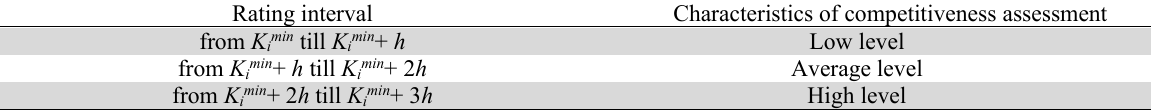
Fig. 1. Number of young people aged 15-29 who completed the transition to the labor market by regions of Ukraine To formalize the assessment of the regions of Ukraine by competitiveness of young people in the labor market, we will make the following transformation: we will give the percentage of young people who completed the transition to the labor market the value of a grade assessment of competitiveness, thus obtaining the corresponding estimates K i youth competitiveness in the labor mar- ket by regions, where і is substring index denoting a specific region ( i = 1...26). We will determine the ratings of the regions of Ukraine and give a description of the corresponding rating. To interpret the obtained competitiveness estimates, we use an interval scale that breaks the resulting assessment range into 3 separate groups, identifying regions with low, medium, and high levels of assessment (Table 4). The scale of assessing the competitiveness of young people in the labor